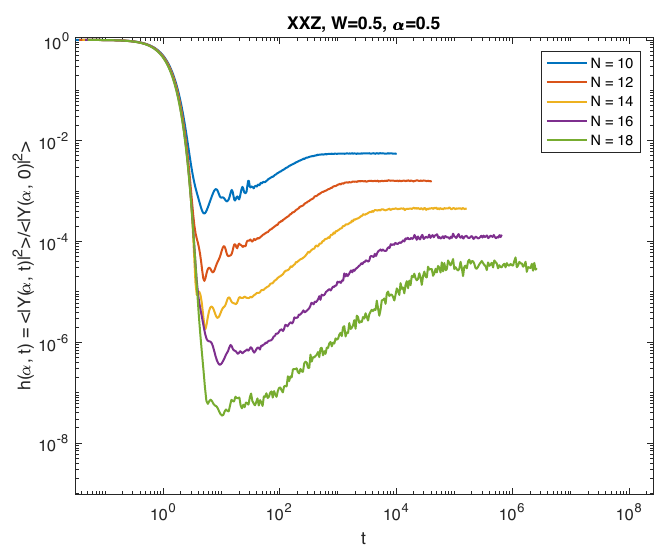
Figure 14 . The spectral form factor for the XXZ Hamiltonian with 10 to 18 qubits for the S=0 sector and W = 0 : 5. We observe universal behavior for the h ( (cid:11); t ), Gaussian decay at the early times, (cid:13)at region, ramp and plateau. The time scale where the ‘bump’ ends and the ramp starts we will again call ramp